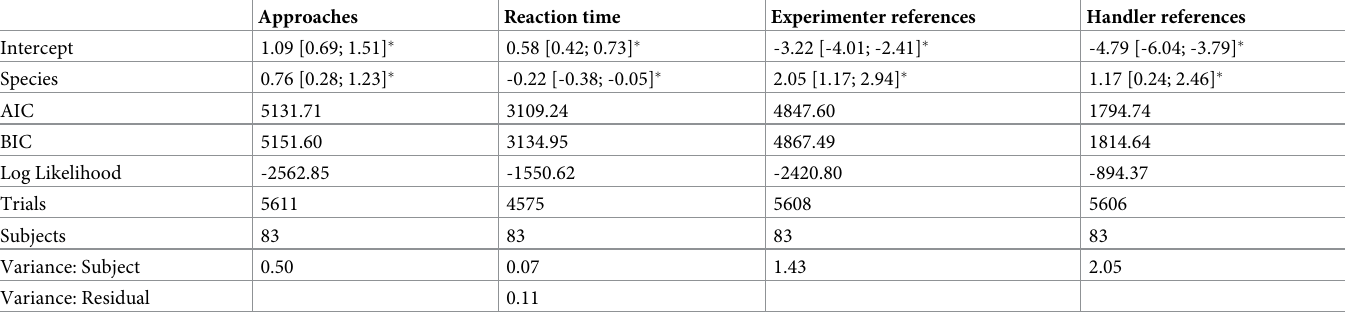
Table 2. Estimates and bootstrapped confidence intervals (N = 500 simulations) of fixed effects in mixed models predicting approach behavior, reaction time and referencing behavior in domestic dogs versus dingoes. Baseline for species was ‘dingo’. Table also shows goodness-of-fit